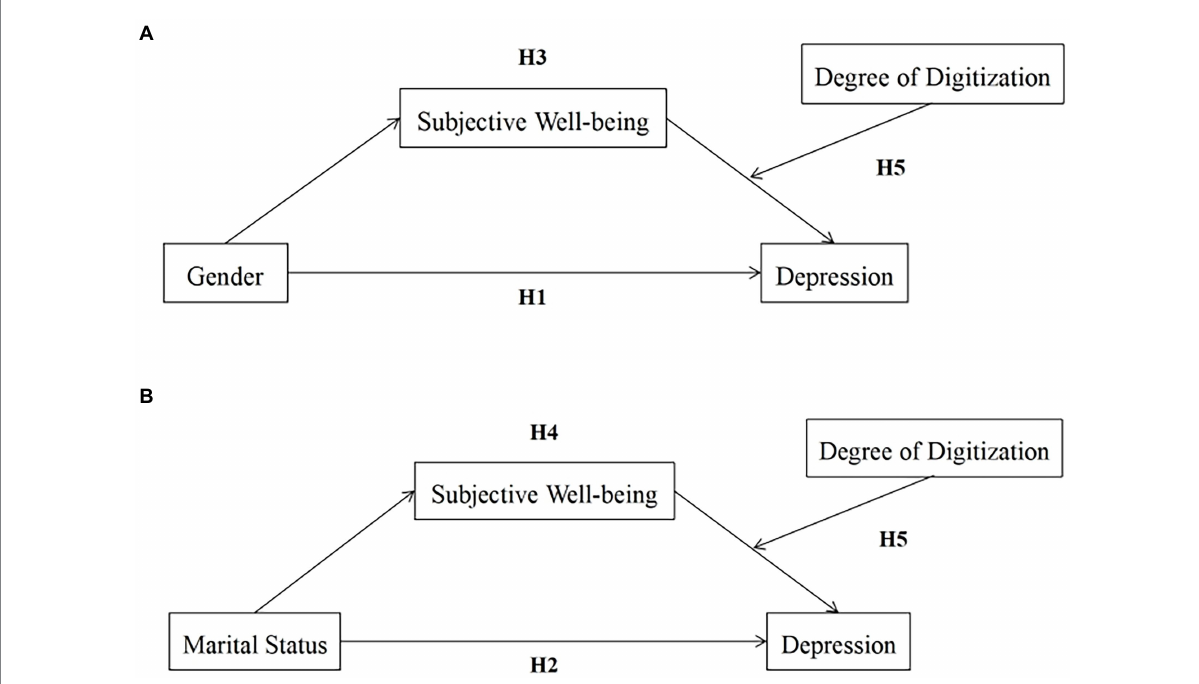
FIGURE 1 The hypothesized model: (A) Hypothetical model between sex and depression; (B) Hypothetical model between marital status and